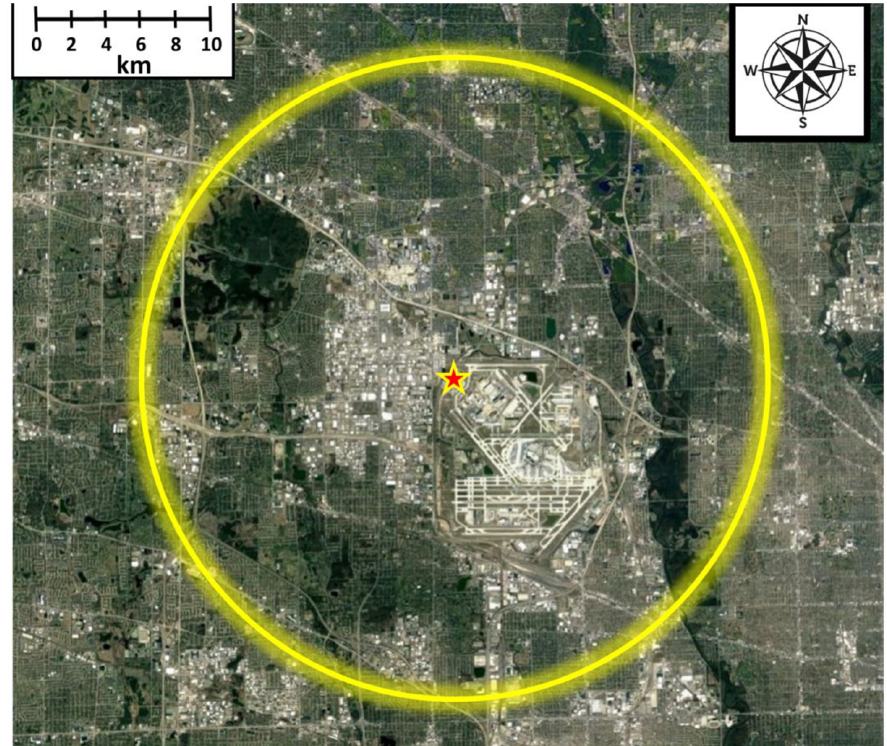
Figure 1. Location of the 3 radar sensors (designated by a star) in relation to the airfield at Chicago’s O’Hare International Airport, USA. The circular lines represent an area around the radars with a 10–km radius (denoted in yellow).